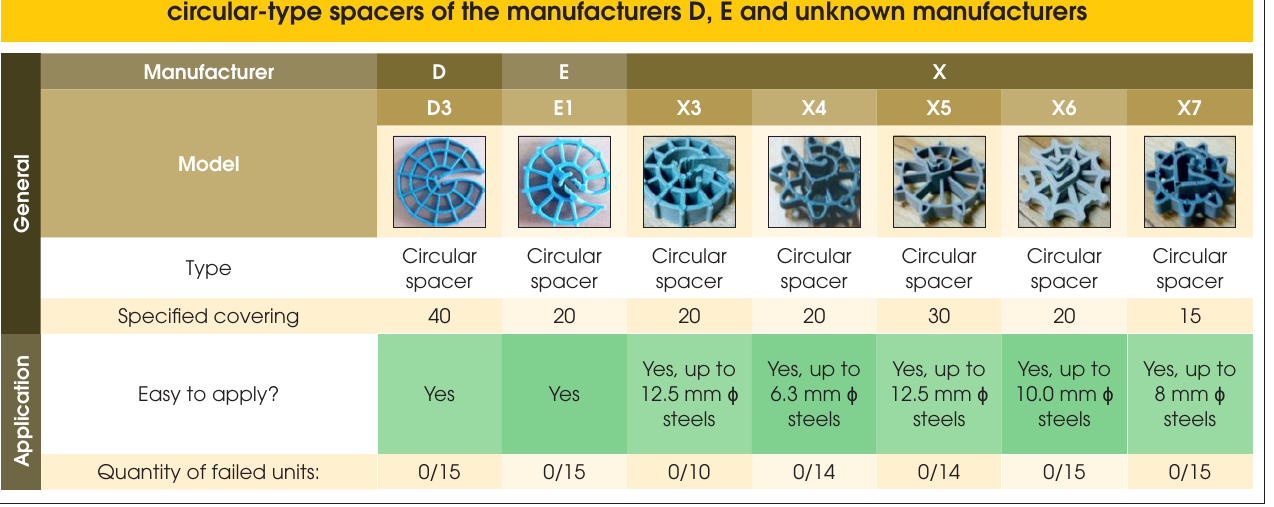
Table 26 – Results of the application requirement evaluation of the circular-type spacers of the manufacturers D, E and unknown manufacturers